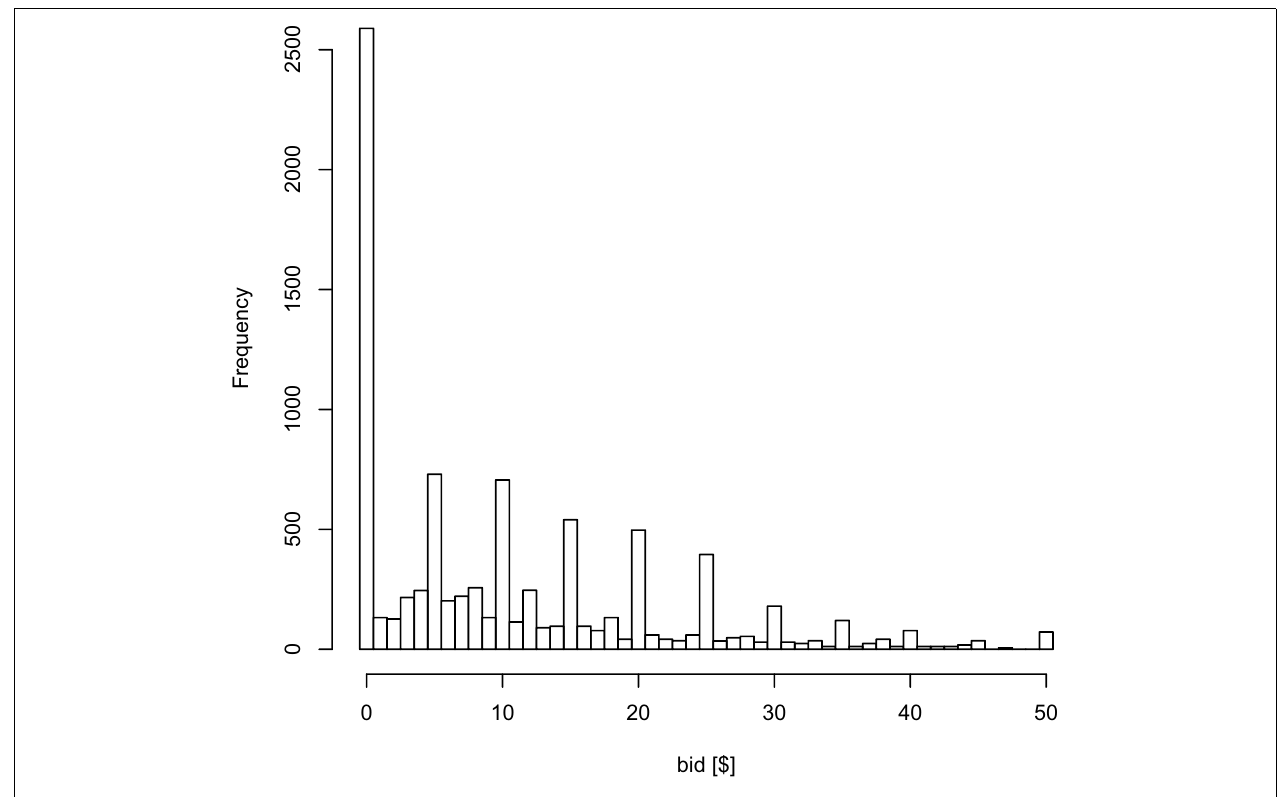
FIGUREA1 | Histogram of the bids for the various products in the BDM task, using all the